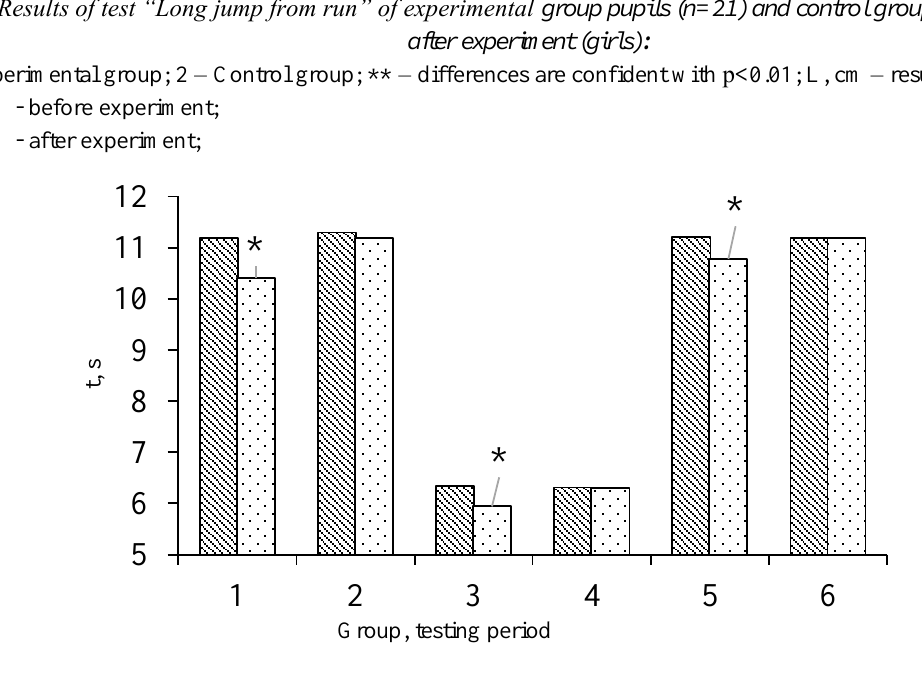
Fig.2. Results of test run tests of experimental group pupils (n=21) and control group (n=22) before and after experiment